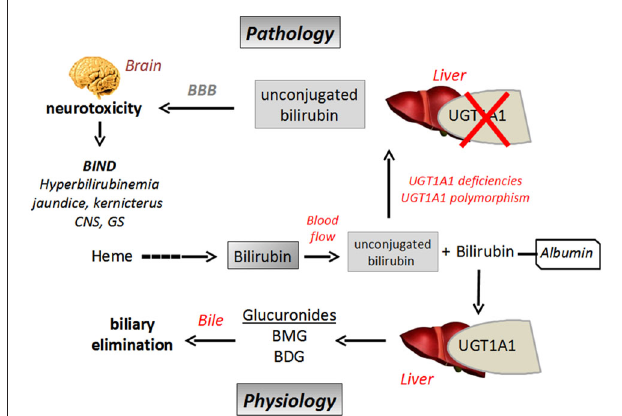
FIGURE 4 | Schematic representation of bilirubin biliary elimination pathway and neurotoxicity in a context of UGT1A1 defect . BBB, Blood Brain Barrier; BIND, Bilirubin Induced Neurological Dysfunction; BMG, bilirubin monoglucuronides; BDG, bilirubin diglucuronide; UGT,